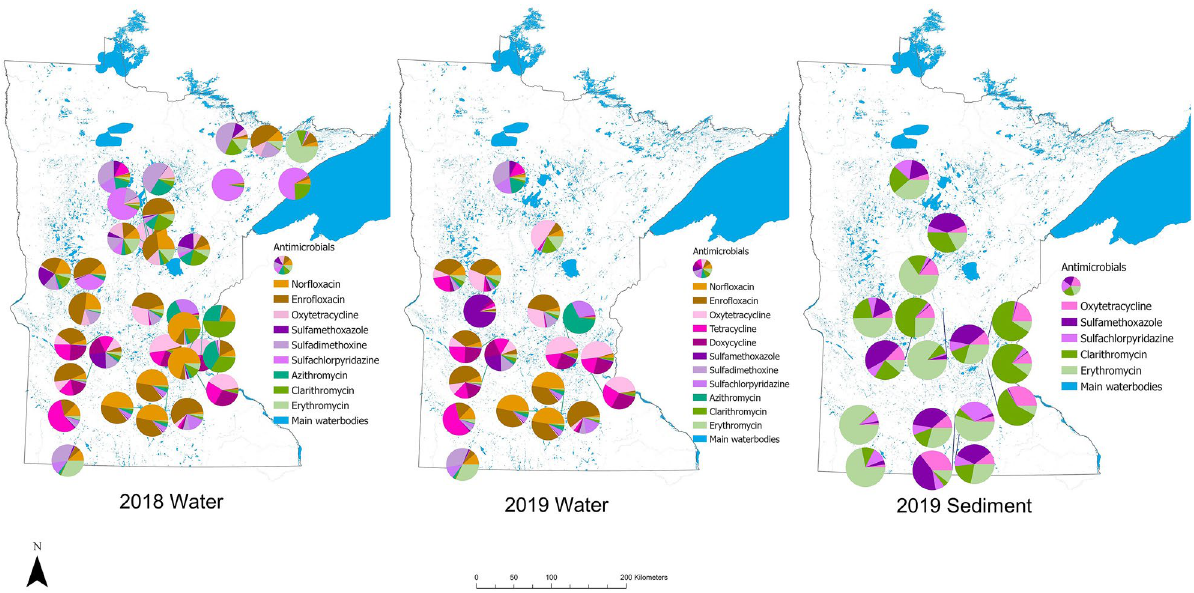
Figure 3. Antimicrobial concentrations for main antimicrobials detected in sampling sites in 2018 (water) and 2019 (water and